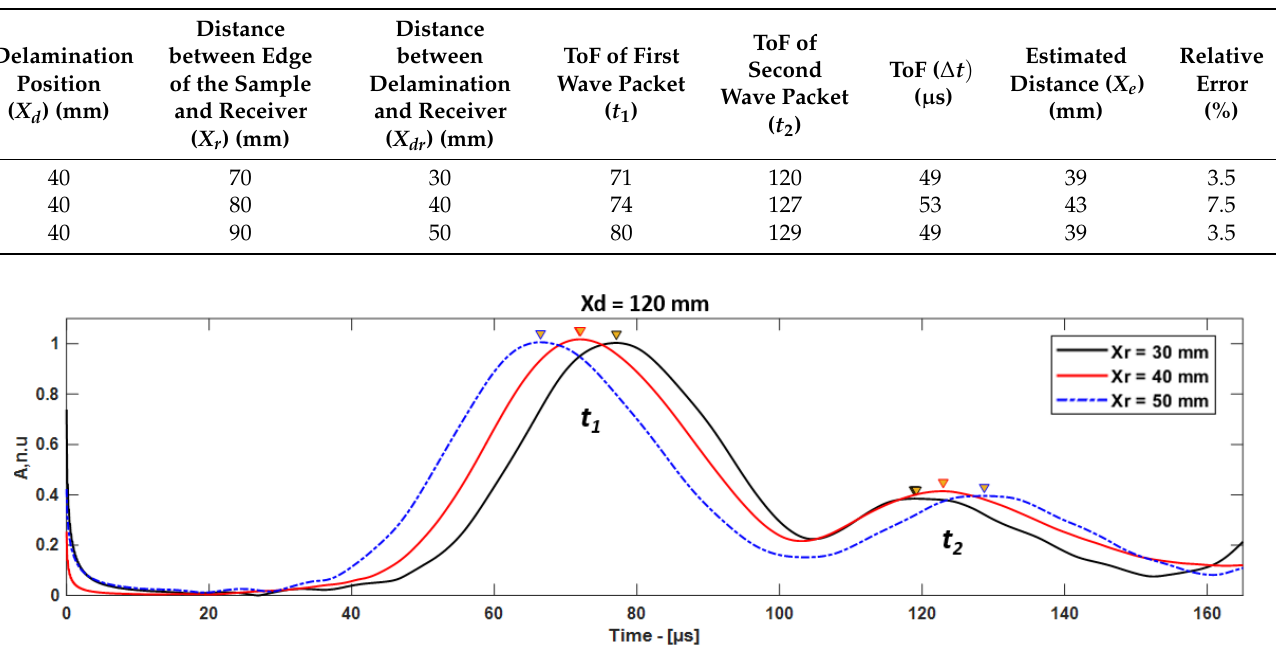
Figure 9. The comparison of ToF of A 0 mode in case of delamination at 120 mm, signals received from different receivers. Table 5. The localization of delamination at 120 mm using different